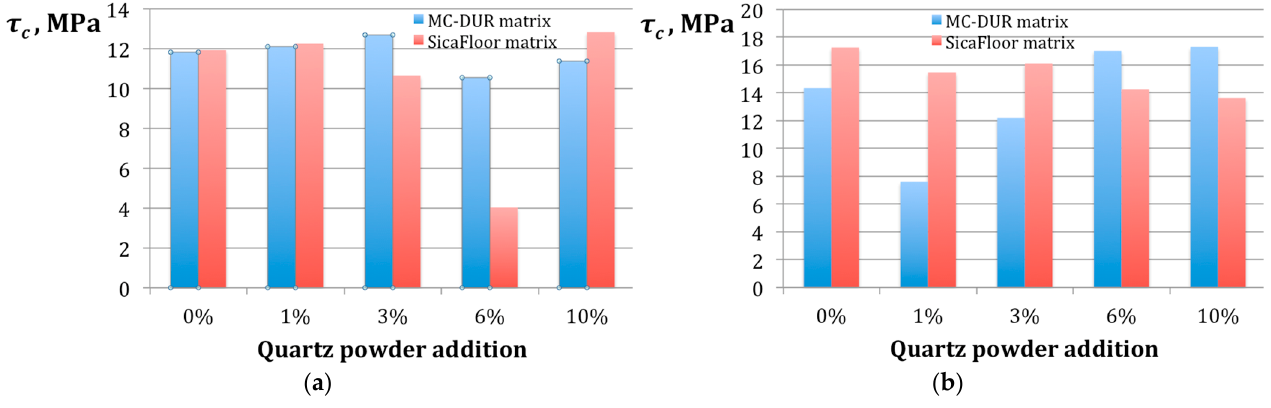
Figure 9. The results of the shear strength τ c measurement for the specimens of the different particulate filler proportions in the polymer matrices MC-DUR 1200VK and Sikafloor 156, produced using different binders: ( a ) with the emulsion binder; ( b ) with the powder binder.